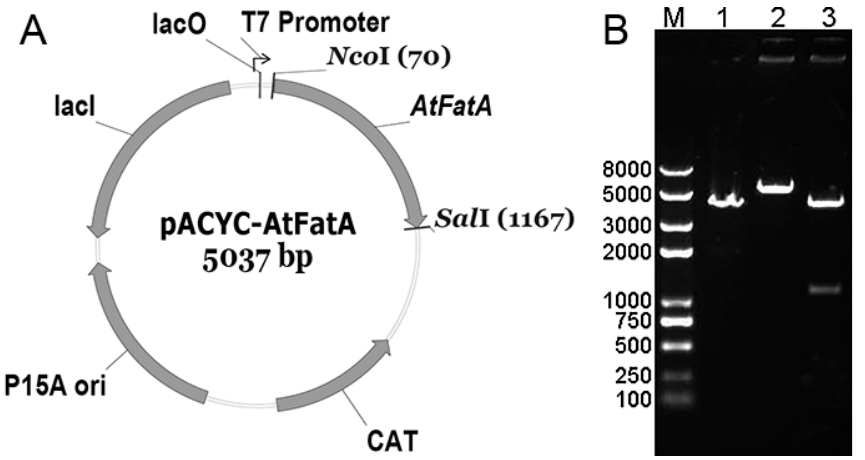
Figure 1. Construction of the recombinant plasmid expressing AtFatA. The AtFatA gene was in- serted into the expression vector of pACYCDuet-1 between Nco I and Sal I. ( A ), Plasmid map of pACYCDuet-1; ( B ), Restriction map of recombinant pACYC-AtFatA, lane M: Trans2K Plus II